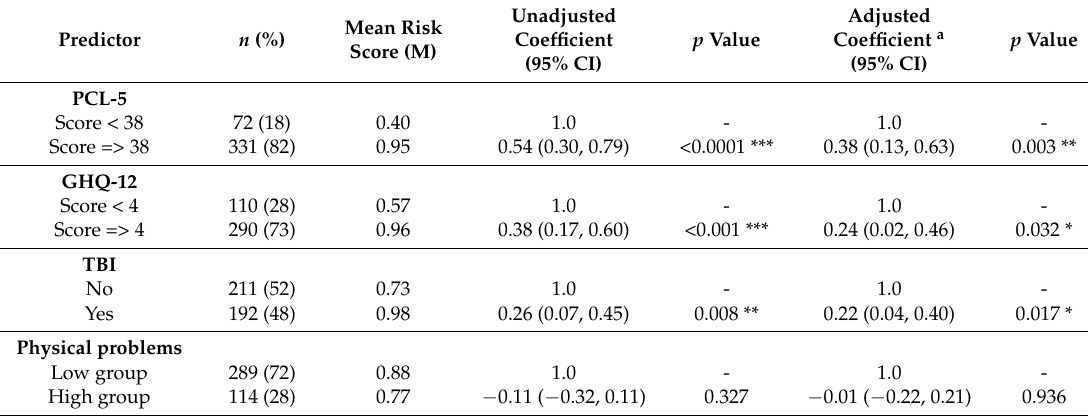
Table 3. Association between health outcomes and risk-taking behavior.